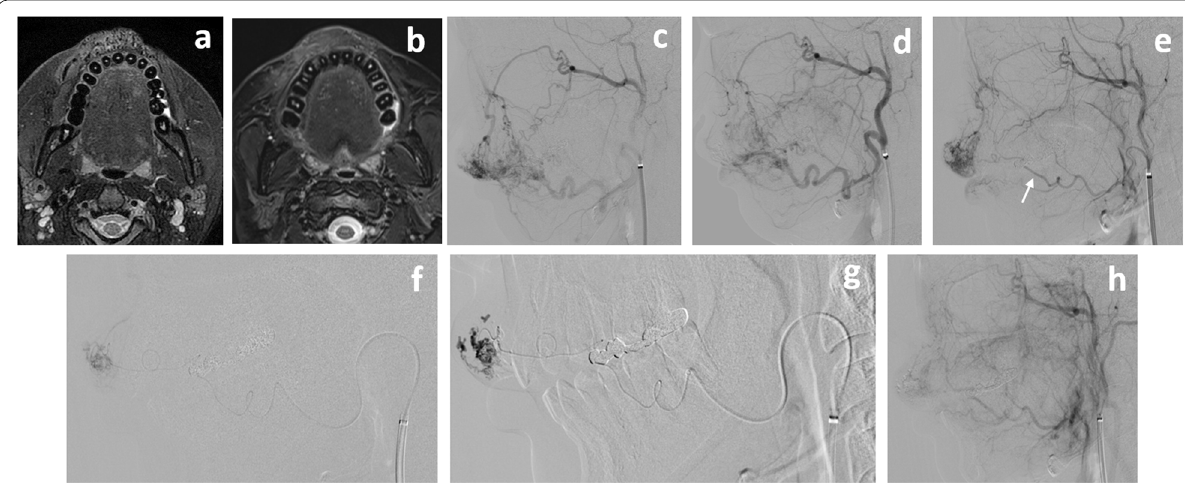
Fig. 3 Angiogram in Case 2 showing high-flow AVMs in the right upper lip that were fed mainly by mainly bilateral SLab As from bilateral FAs and which drained into the right facial and angular veins. The lesion was diagnosed in accordance with Cho’s classification as type IIIa AVM. ( a ) Fat-saturated T2WI MRI showing high-signal intensity with multiple flow voids in the upper lip before treatment. ( b ) Fat-saturated T2WI MRI 3 months after the last embolization session showing regression of the soft tissue swelling and disappearance of the flow voids. ( c ) Right external carotid arteriogram, lateral view, before the first embolization session. ( d ) Right external carotid arteriogram showing partial devascularization of the AVM after embolization of the right SLab A during the first session. ( e ) Left external carotid arteriogram, lateral view, before the second embolization session showing residual AVMs fed by the SLab A (white arrow). ( f ) The microcatheter was navigated into the distal feeder from the left SLab A in the second embolization session. ( g ) Angiogram, lateral view, showing the nBCA injection under flow control. The nBCA-lipiodol mixture filled the shunting points and the distal draining veins. ( h ) Left external carotid arteriogram showing that the AVMs near-completely disappeared after embolization of the left SLab A during the second